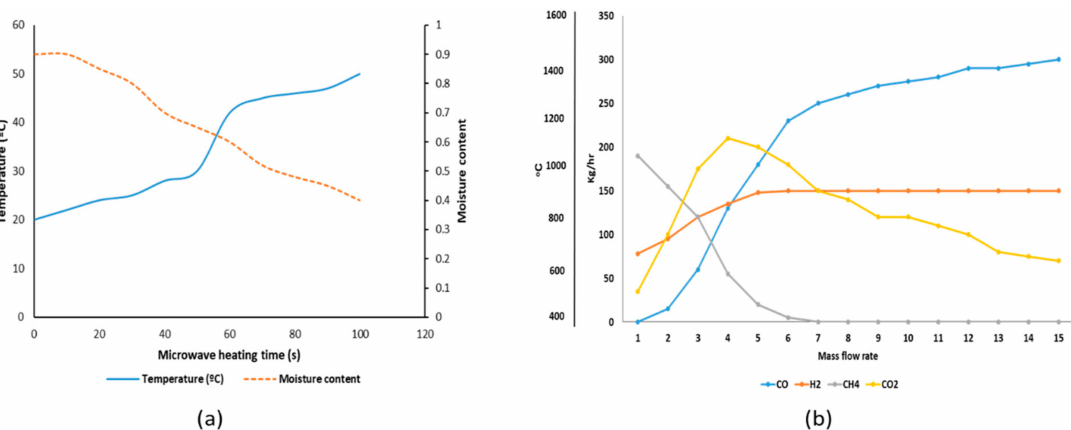
Figure 2. ( a ) Microwave heating time relative to moisture content and temperature variation. ( b ) Mass flow relationship relative to the influence of temperature change on the composition of syngas.